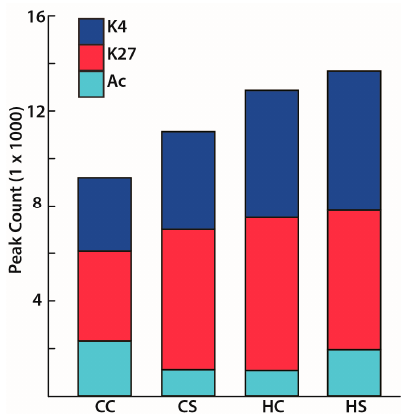
Figure 5. Enriched histone modification peaks overlapping 5 kb upstream region of known transcriptional start site. All H3Ac (Ac), H3K4me3 (K4), and H3K27me3 (K27) enriched peaks